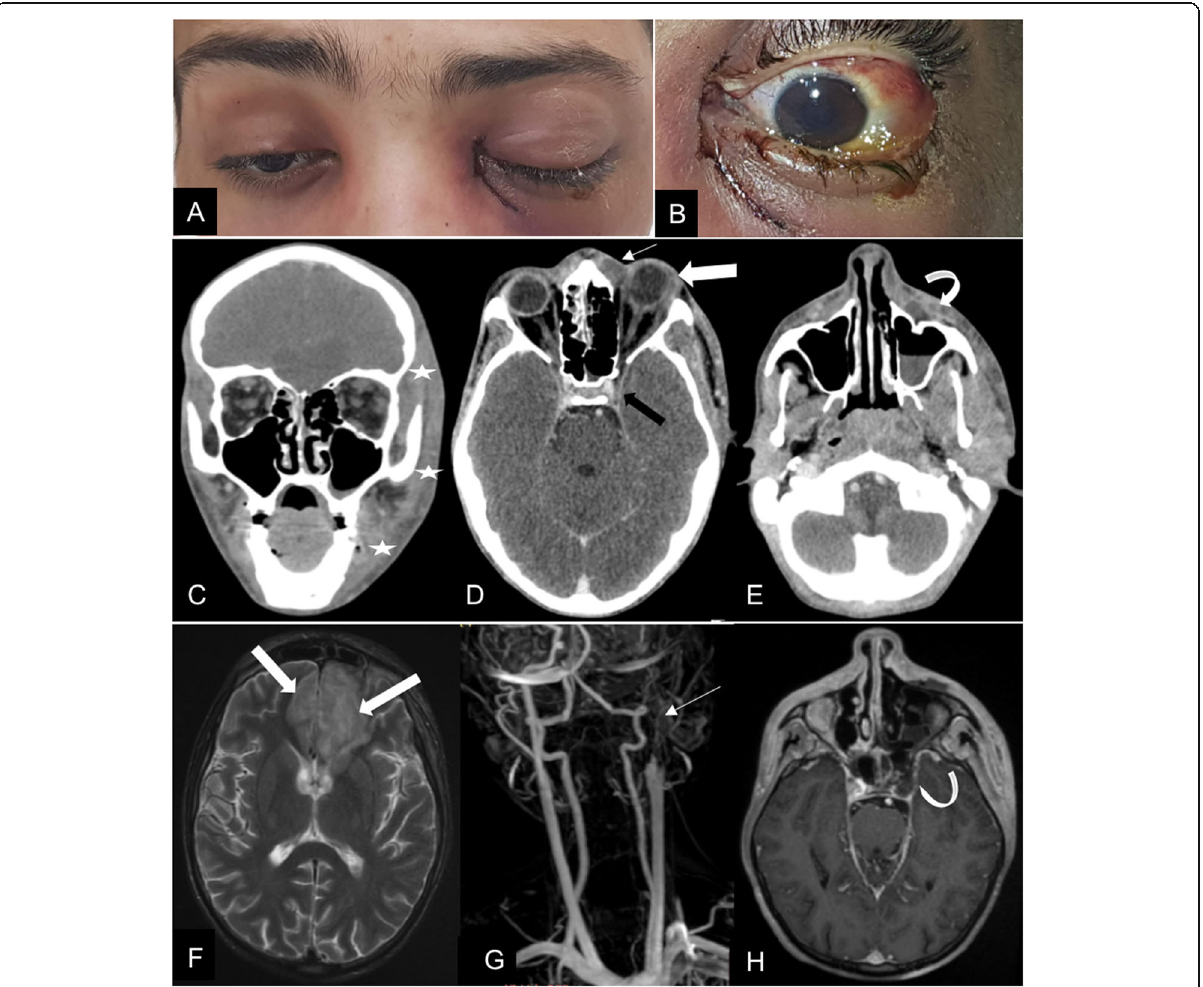
Fig. 1 A 20-year old COVID-19-affected patient presented with rhino-orbitocerebral mucormycosis. ( A ) Complete blepharoptosis and inflammatory signs are seen on the left side. There is a mild proptosis on the right side. ( B ) Note the conjunctival injection, the chemosis and the corneal oedema. ( C ) Coronal and ( D , E ) Axial contrast-enhanced brain CT scan show thickening with infiltration of left hemiface fat planes (white stars); left pre-septal collection (arrow) with exophthalmos and lengthening of the antero-posterior axis of the eyeball (large arrow). This collection reaches the cellulo-fatty tissues next to the left maxillary sinus (curved arrow), the latter is the site of a partial liquid filling. The left cavernous sinus shows signs of thrombosis (black arrow). ( F ) axial T2 weighted image MRI showing T2 hypersignals (large arrow) in areas of the frontal lobes confirming endocranial extension. ( G ) MR angiography shows left carotid artery thrombosis (arrow). ( H ) 3D T1 weighted sequence with contrast shows left cavernous sinus thrombosis (curved